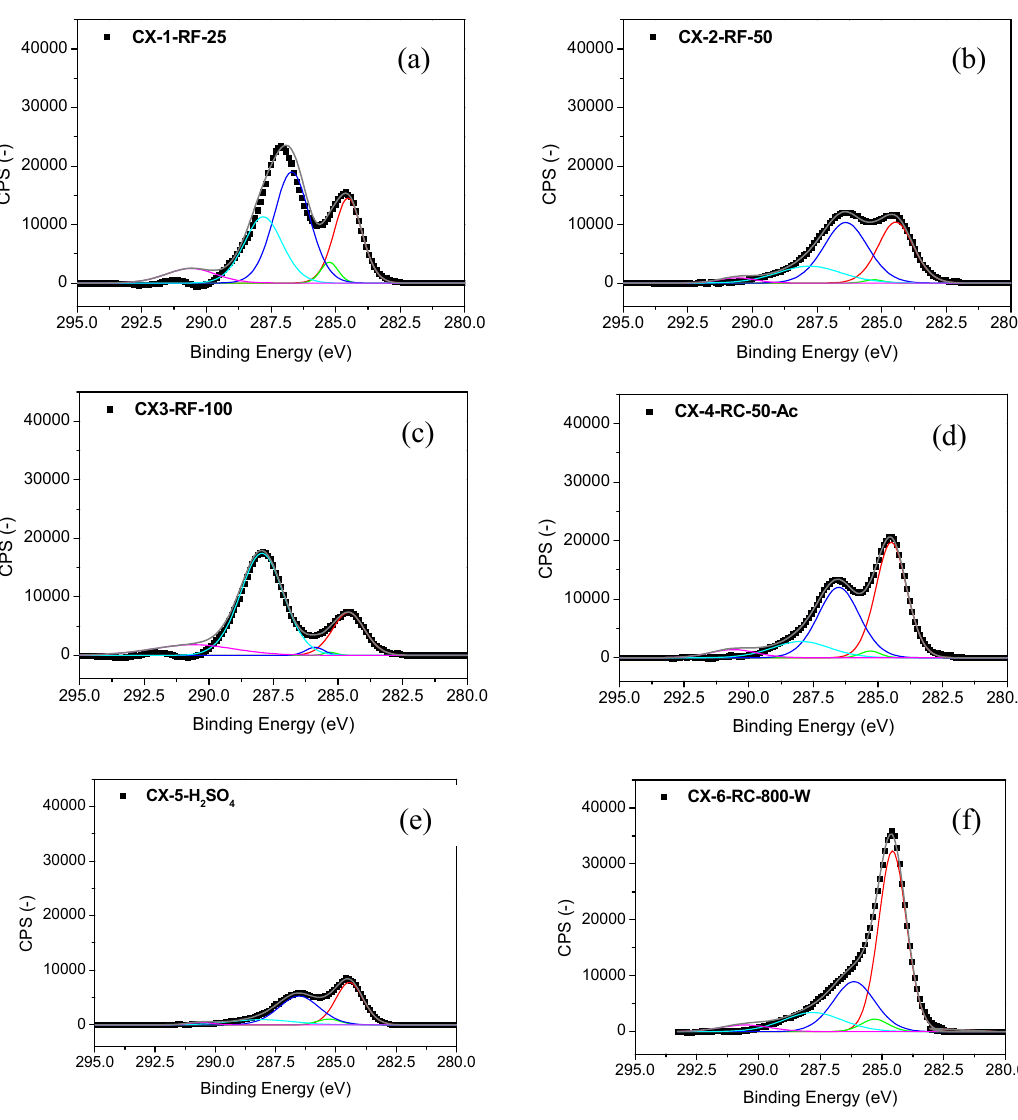
Figure 1 . XPS C 1s band and deconvolution for the different carbon xerogels prepared ( a–h ), and Vulcan carbon black ( h ).